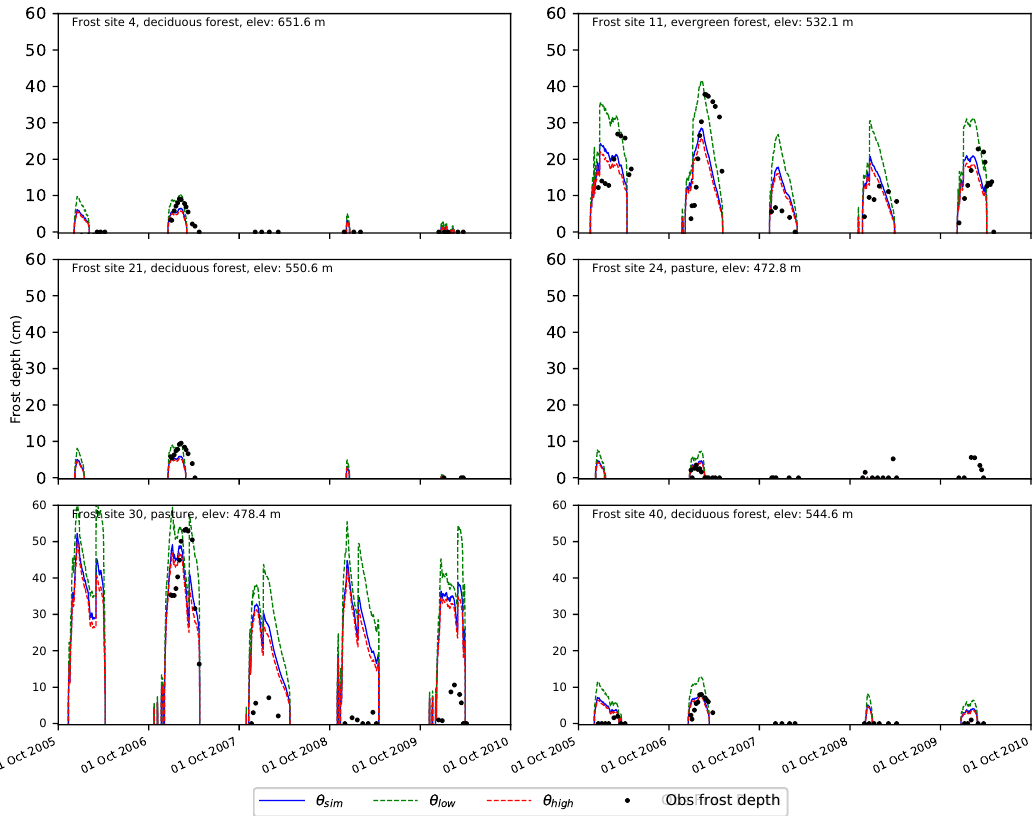
Figure 9. Simulated frost depths from the modCFGI model using simulated soil moisture ( θ sim ) , a constant high soil moisture ( θ high ) , and a constant low soil moisture ( θ low ) at all six selected frozen ground test sites within the W-3 watershed.